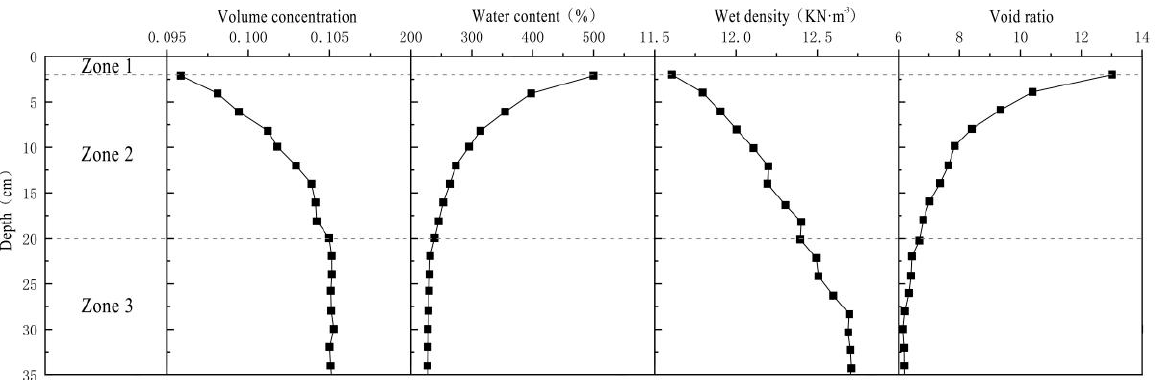
Figure 3. The variations in the physical properties of deep-sea sediments with depth in the ocean polymetallic nodule exploration areas [29].